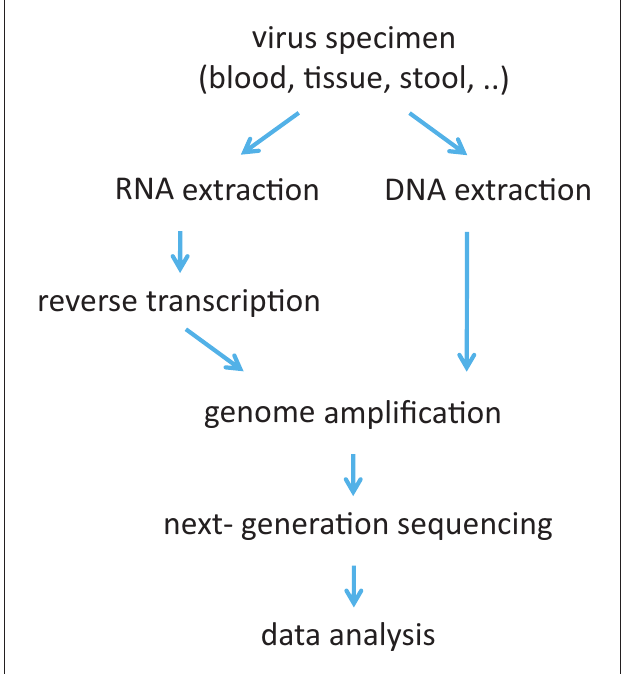
FIGURE 1 | Flow chart of sample processing for next-generation sequencing (NGS) of virus